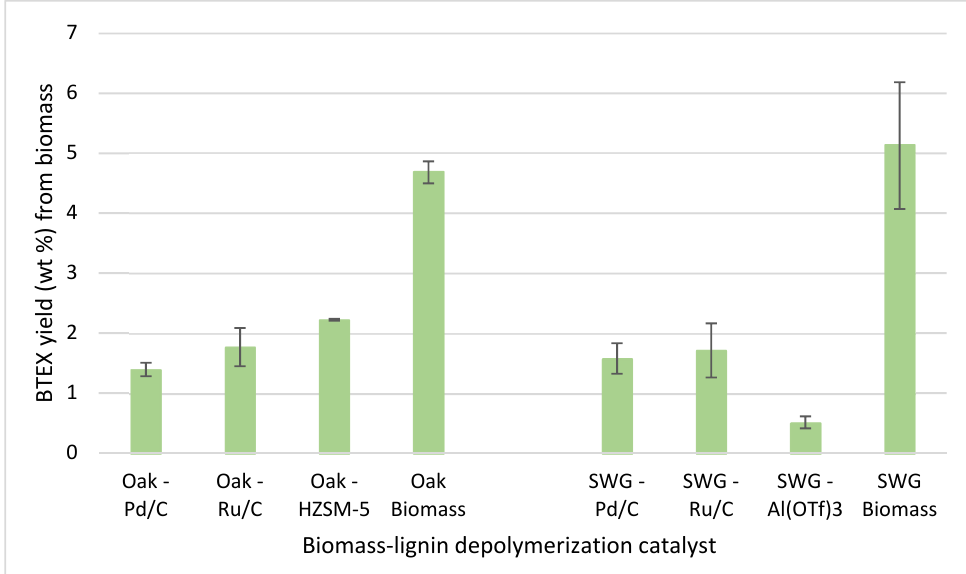
Figure 6. BTEX yield (wt %) from HZSM-5-catalyzed pyrolysis of cellulosic pulps isolated after lig- nin- fi rst fractionation in ethanol at 210 °C. Pyrolysis at 550 °C, catalyst:biomass ratio of 5:1 ( w/w ). Error bars are one standard deviation.